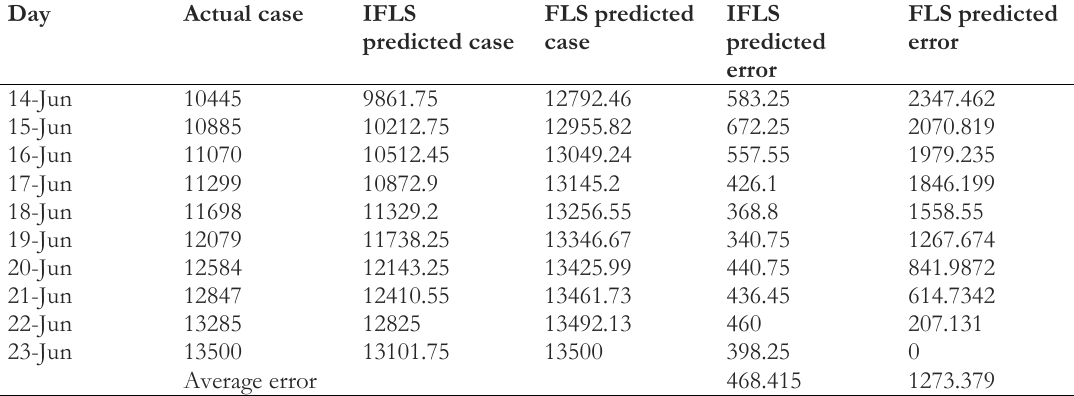
Table 4. Comparison of actual and predicted COVID-19 active cases using IFLS and traditional Type-1